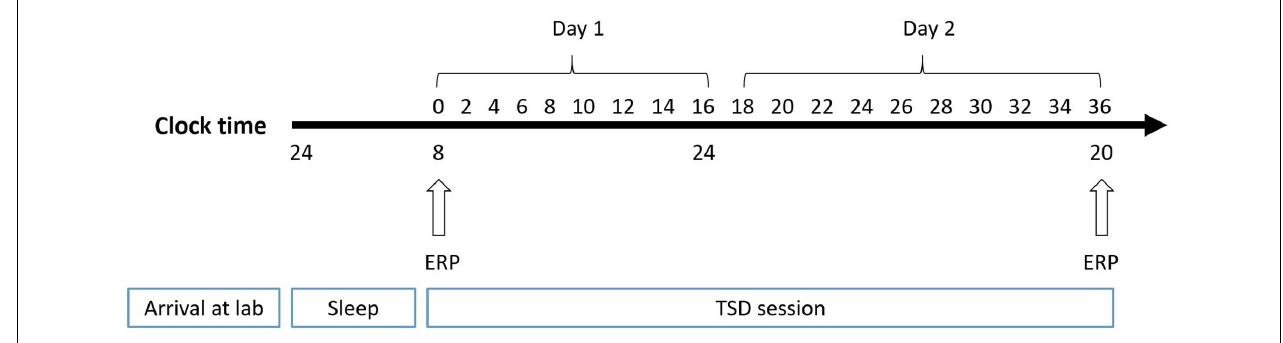
FIGURE 2 | Experimental design. After 8 h of sleep in lab, participants experienced 36-h TSD. The arrows indicate the time points during the 2-back spatial working memory task and EEG recording simultaneously.